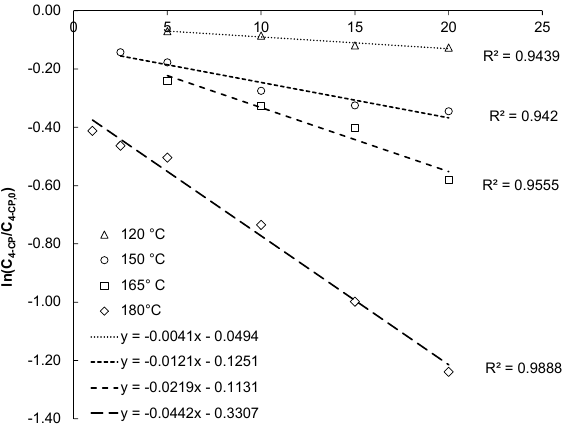
Figure 1. Determination of the reaction rate constants. Conditions: C 4-CP,I = 5000 mg/L; C H2O2,I = 11 g/L. The pre-exponential factor k 0 and activation energy E a were also obtained graphically, by plotting the natural logarithm of the obtained reaction rate constants as a function of the inverse of their respective temperatures (Figure 2). From this linear fit, the activation energy and pre-exponential factor can be derived. This results in an activation energy of 57.6 kJ/mol and a pre-exponential factor of 171,442 min − 1 .